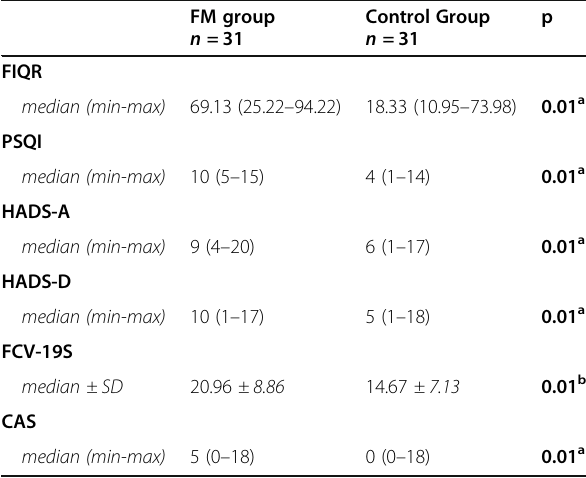
Table 2 Comprassion of results of Fibromiyalgia Impact Questionnare, Pitsburg Sleep Quality Index, Hospital Anxiety and Depression Scale, Fear of COV İ D-19 Scale, and Coronavirus Anxiety Scele between two groups